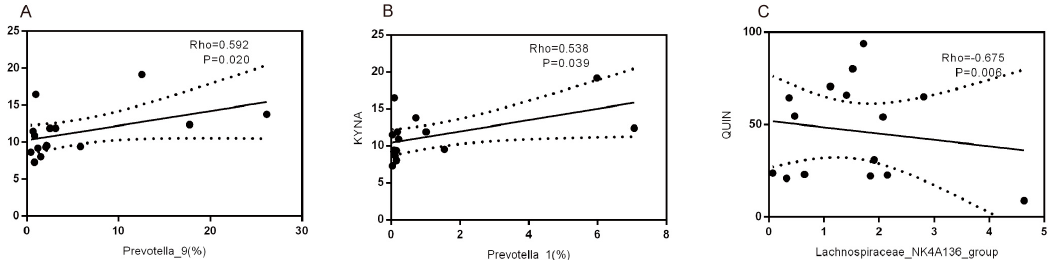
Figure 8. Correlation between KYNA content and the relative abundance of the genera, Precotella_9 ( A ) and Prevotella_1 ( B ). Correlation between QUIN content and abundance of the genus, Lachnospiraceae_NK4A136_group ( C ). Spearman rank correlation (R) and probability ( p ) were used to evaluate statistical significance.